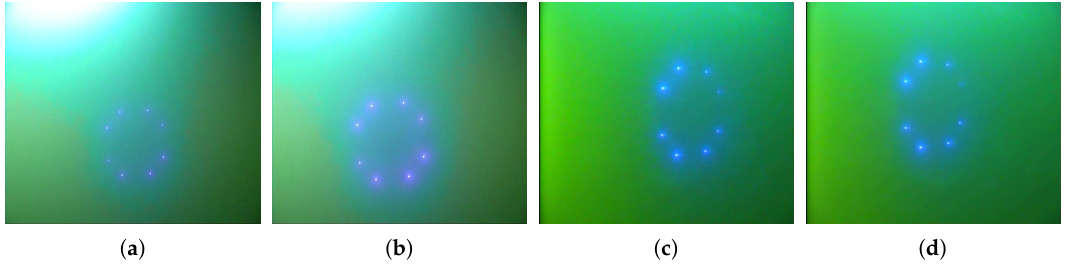
Figure 2. ( a , b ) Ambient light in AUV recovery in shallow water; ( c , d ) nonuniform spreading of landmarks in AUV